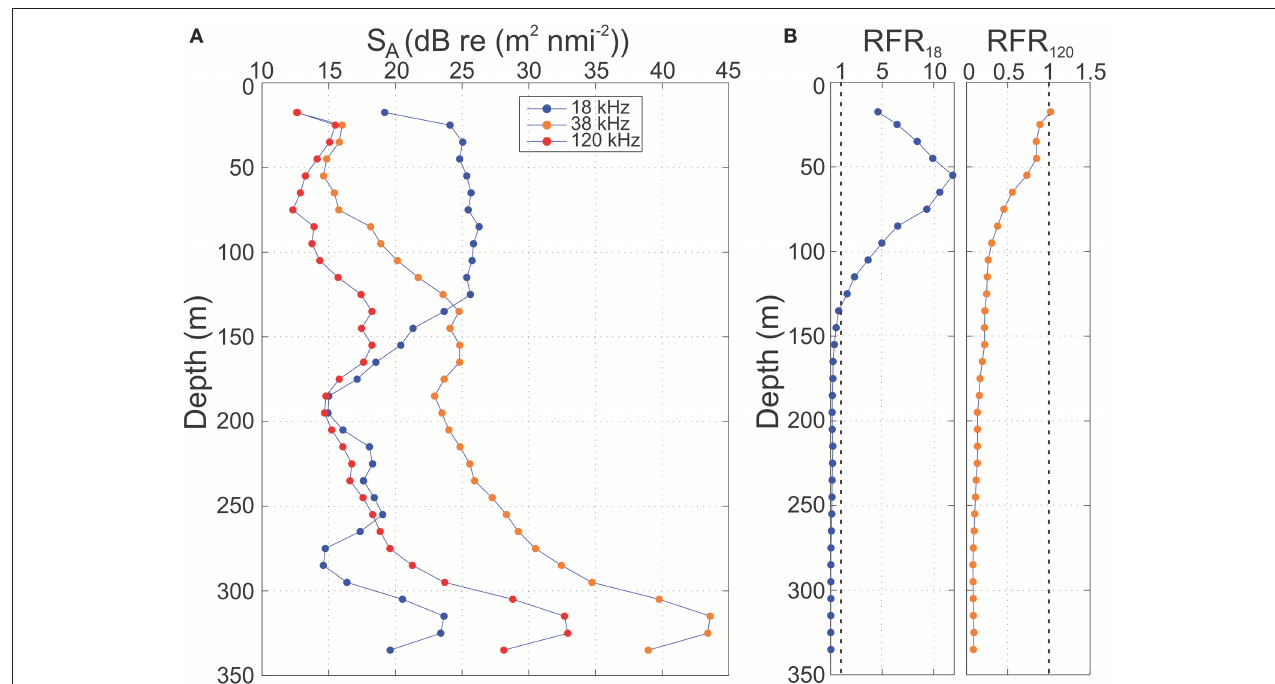
FIGURE 11 | (A) Vertical structure in acoustic backscatter, presented as nautical area scattering strength, S A = 10log 10 (s A ), over a 3.5 nmi distance (Log 8623.4-8626.9, cf. Figure 10 ) for the frequencies 18, 38, and 120kHz from RV Helmer Hanssen on 7 November 2015. (B) Relative Frequency Response RFR for 18 and 120kHz respectively vs. depth. Stippled vertical lines indicates when the RFR ratio is equal to 1. The volume backscattering strength threshold S v,t = − 82 dB re 1m − 1 . Note, x-axes are